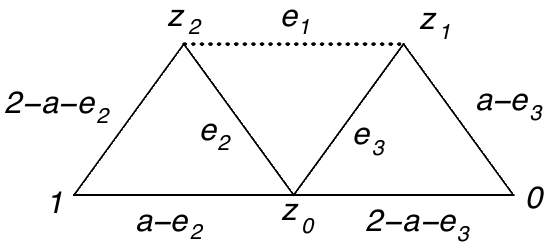
Figure 18 . Correlator de(cid:12)ning the function (cid:3)( (cid:15) i ) ( (cid:17) (cid:3)( e i )) in eq. (D.1). Dotted line depicts the unusial propagator [ z 2 + ( z 1 y + z 2 y ) 2 ] (cid:0) e 1 between points z 1 and z 2 12 x